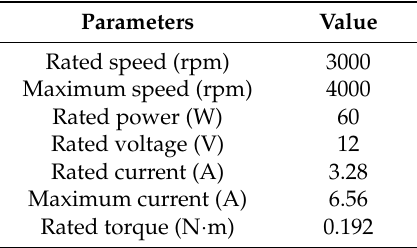
Table 3. Parameters of DC motor of seed-metering